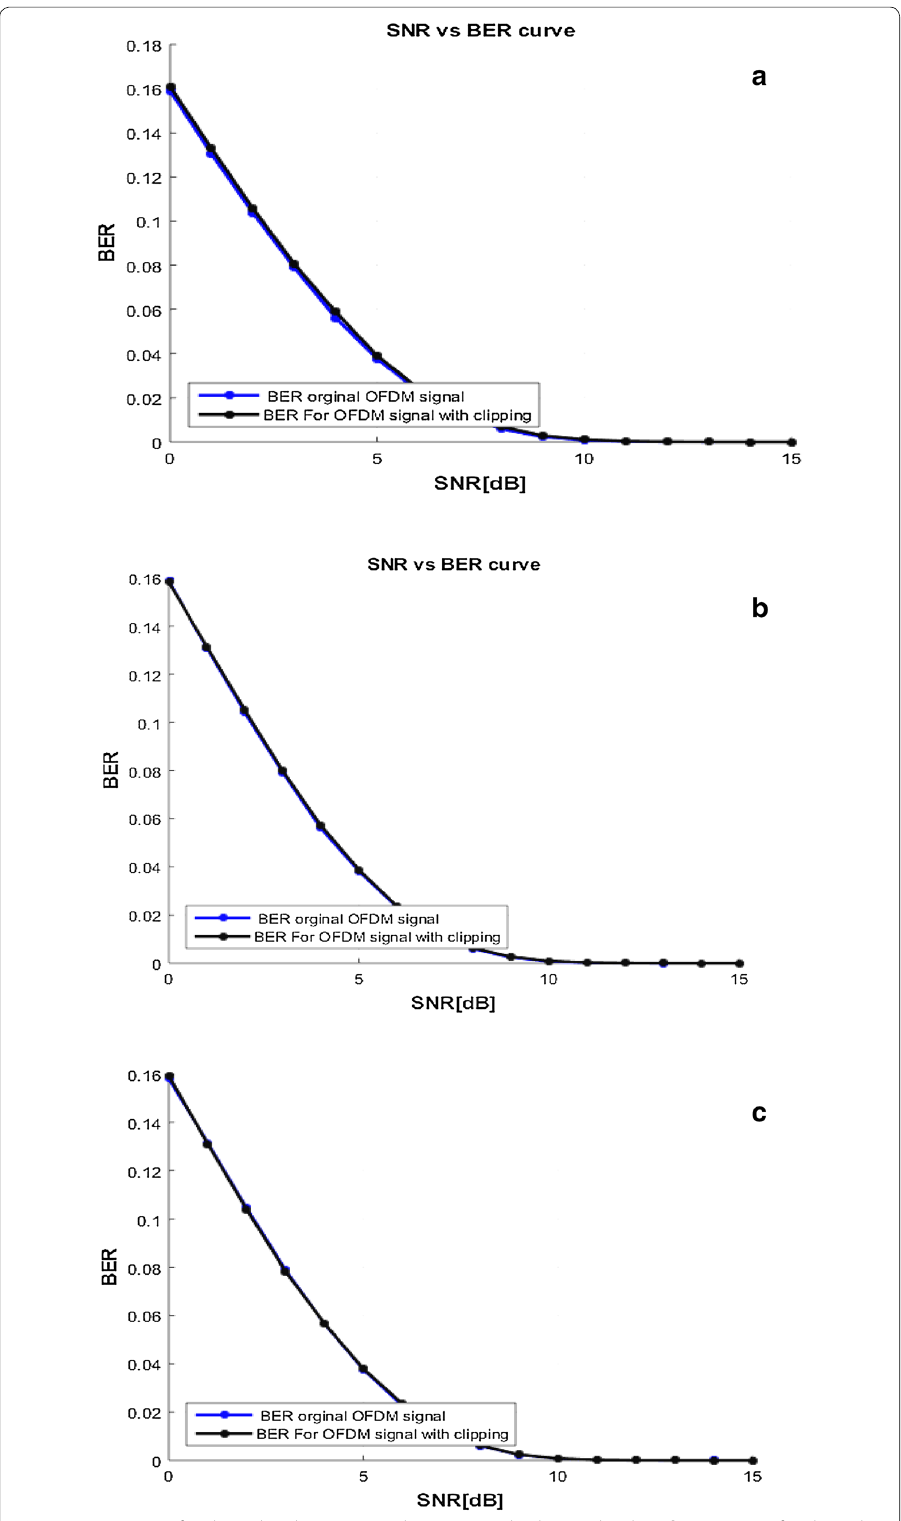
Fig. 4 a SNR vs BER for clipped and conventional OFDM signals, clipping level 0.7; b SNR vs BER for clipped and conventional OFDM signals, clipping level 0.8; c SNR vs BER for clipped and conventional OFDM signals, clipping level